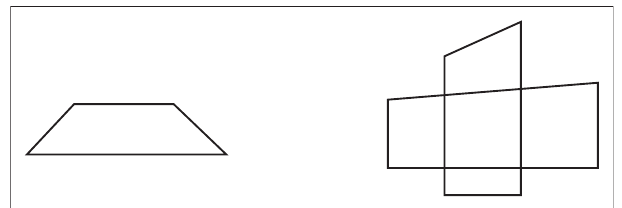
FIGURE 6: Different orientations of trapezoids.